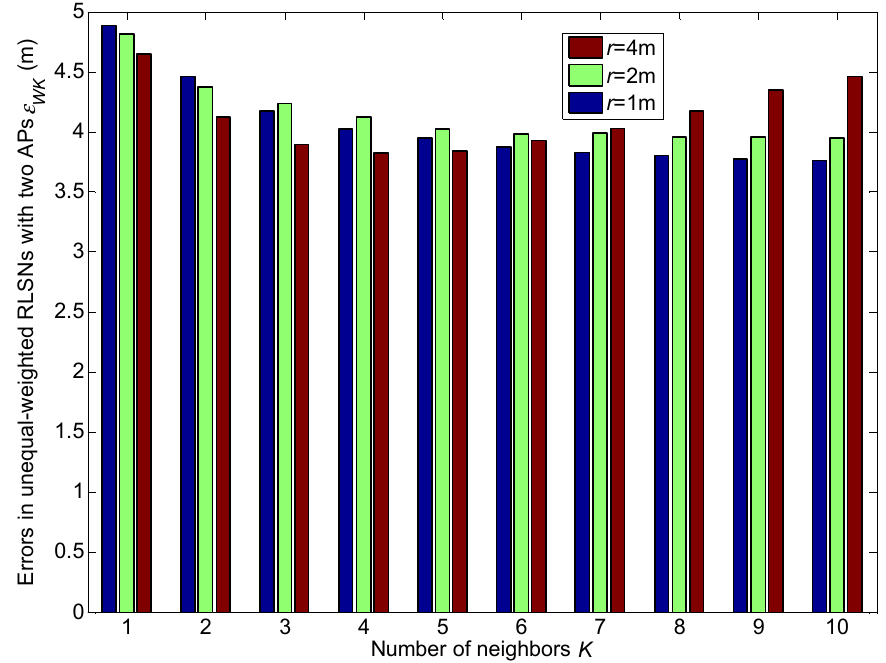
Figure 19. Localization errors in unequal-weighted RLSNs with two APs (AP1 and